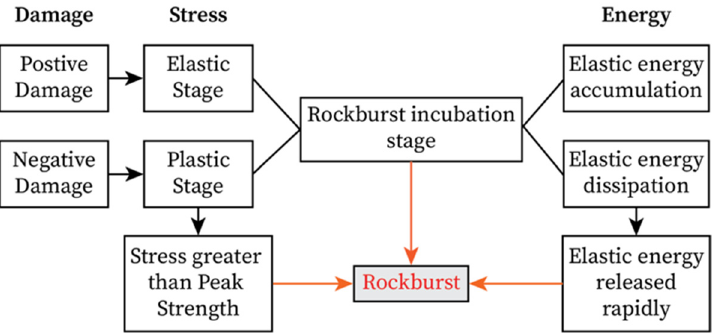
Figure 7. Stress–energy mechanism of rockburst preparation and development (modified from ref. [122]).